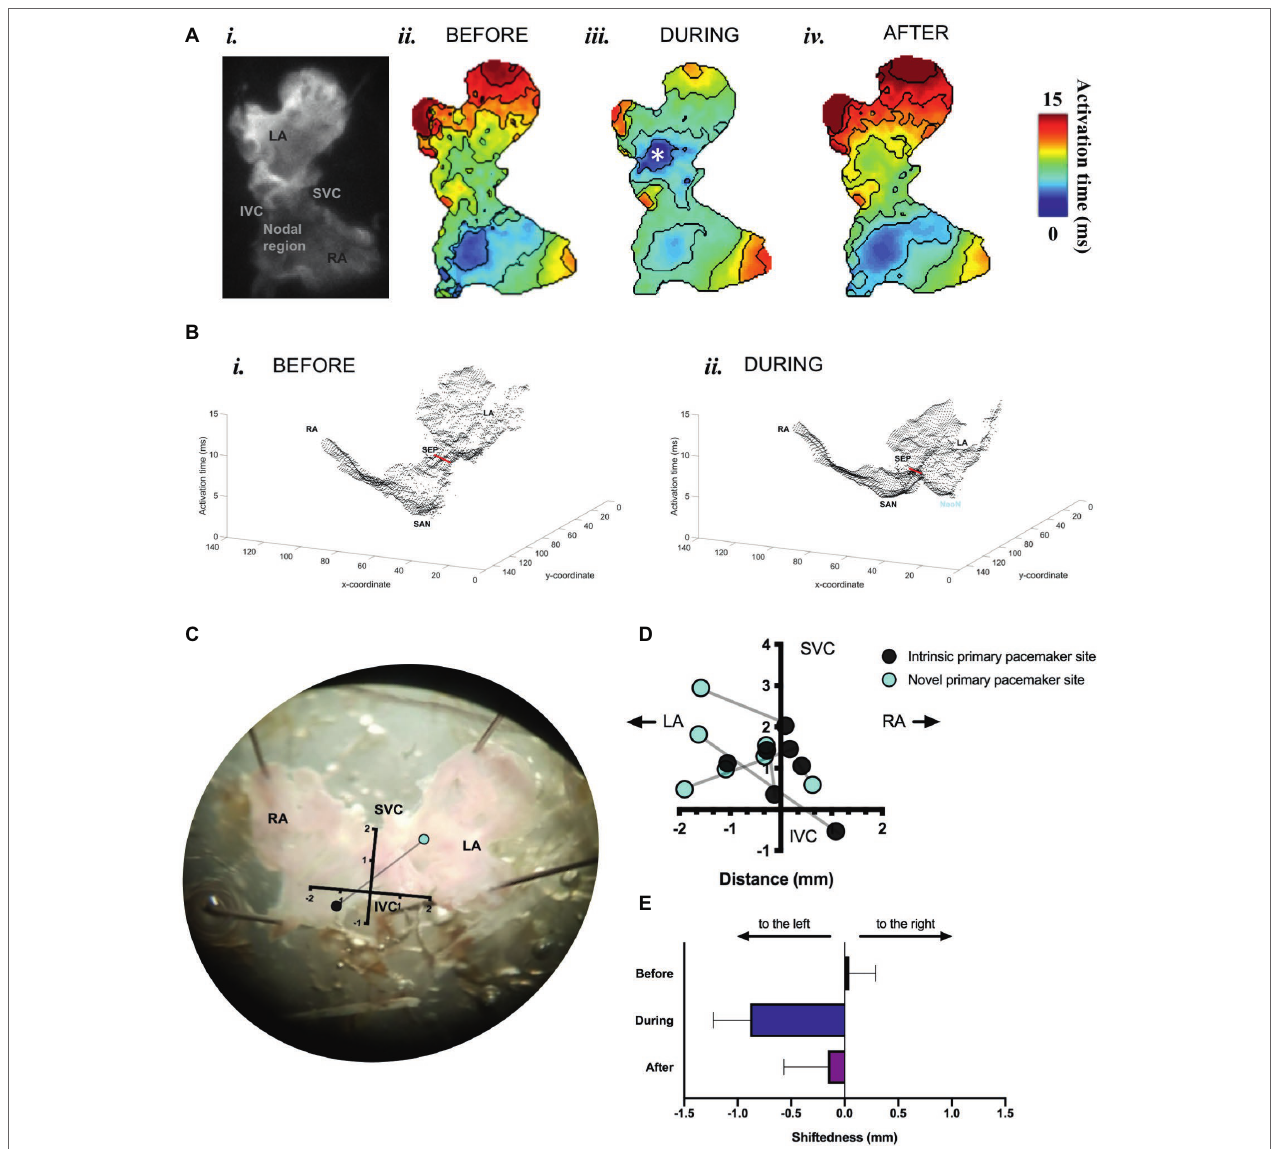
FIGURE 5 | Mapping of activation in SAPs under sinus rhythm and under optogenetic pacing. (A) ( i ) Representative SAP—camera view. ( ii ) Activation map for this SAP before optogenetic pacing. ( iii ) Activation map during pacing (note formation of “neonode”, white asterisk). ( iv ) Activation map after pacing. Activation maps are calculated from Ca 2+ transients. Fifty pacing spikes given, at 6.67 Hz. Contours drawn at 1/frame rate of the EMCCD. Scale bar, right. (B) 3-D graphical rendering of activation maps ( i ) before pacing, ( ii ) during pacing. SVC-IVC axis in red. Activation time on z-axis. (C) Representative SAP—microscope view. Pacemaker shift overlaid. SVC-IVC axis shown. Distances in mm. (D) SVC-IVC axis with relative pacemaker shifts plotted ( n = 7). (E) Mean change in “shiftedness.” LA, left atrium; RA, right atrium; SAN, sinoatrial node; SVC, superior vena cava; IVC, inferior vena cava; SEP, septum; NeoN,